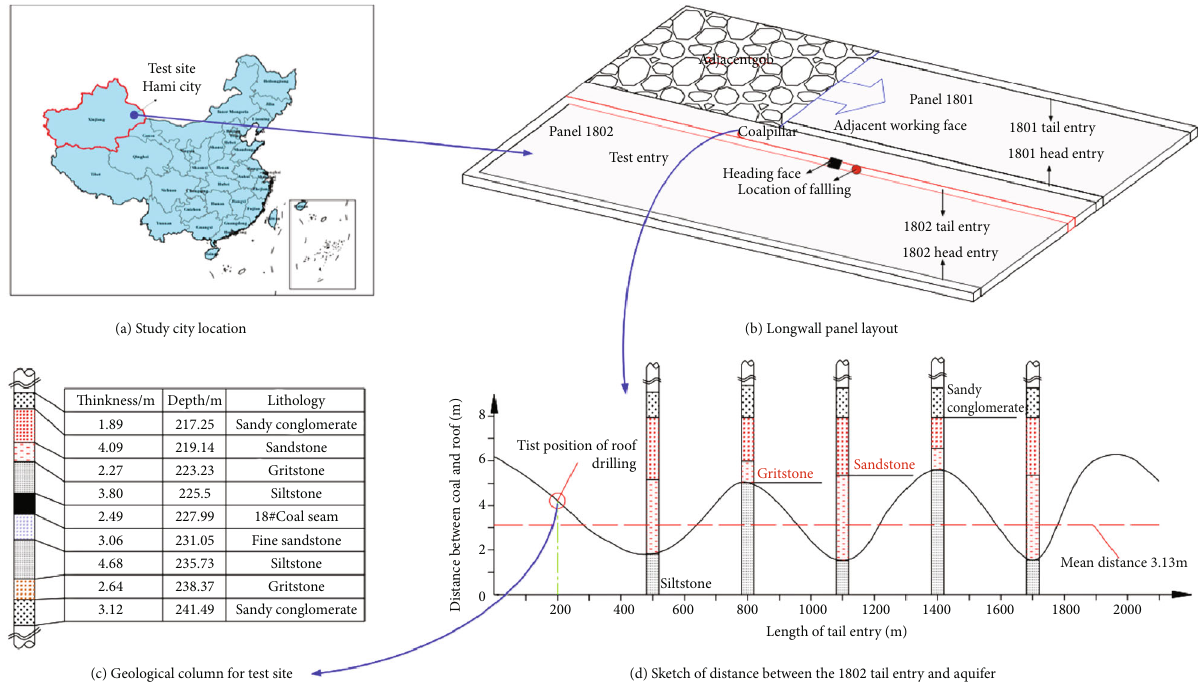
(d) Sketch of distance between the 1802 tail entry and aquifer(c) Geological column for test site